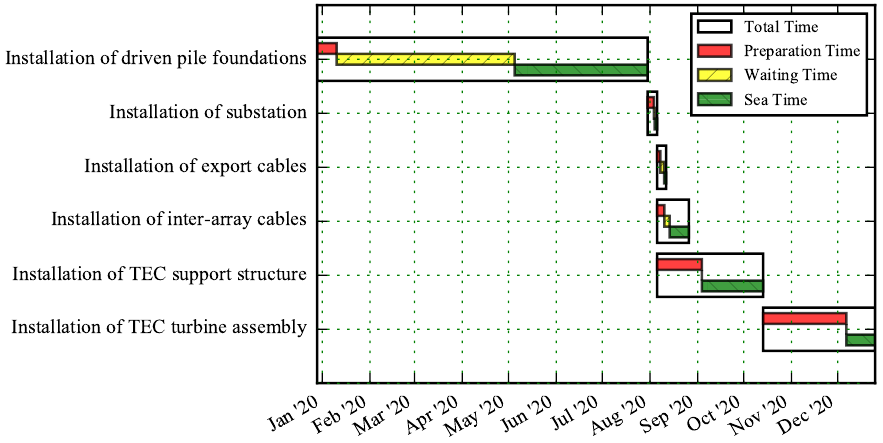
Figure 15. 50 TEC DTOcean simulation installation phases Gantt chart. Please note that time categories (such as waiting time) are aggregated and may occur at different intervals than shown.